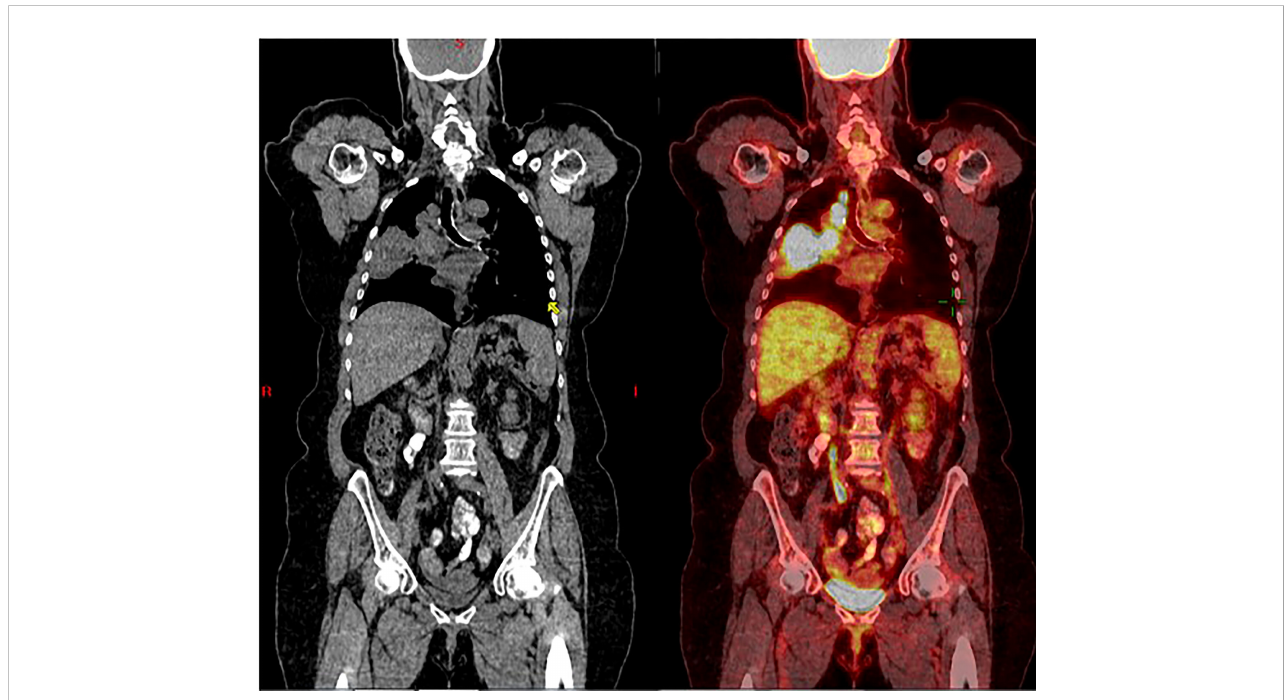
FIGURE 1 Coronal CT scan (left), and superimposed PET scan (right), from March 2016, show a large right lung mass (>5 cm) with increased uptake of FDG-18. There is also ipsilateral hilar and paratracheal lymphadenopathy with positive PET uptake, contributing to classi fi cation as unresectable, stage 3B